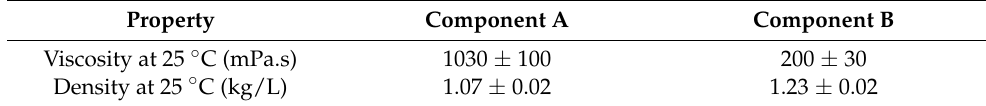
Table 1. Physical properties of ESPAK90 components.